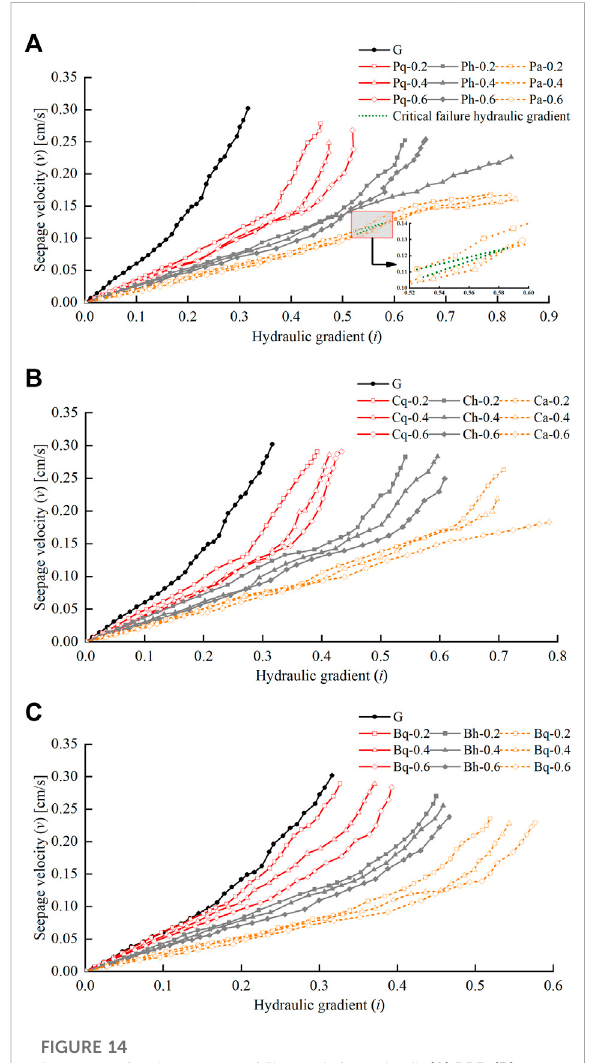
FIGURE 14 i – v curves for three types of fi ber-reinforced soil: (A) PPF; (B) CF; (C) BTF.